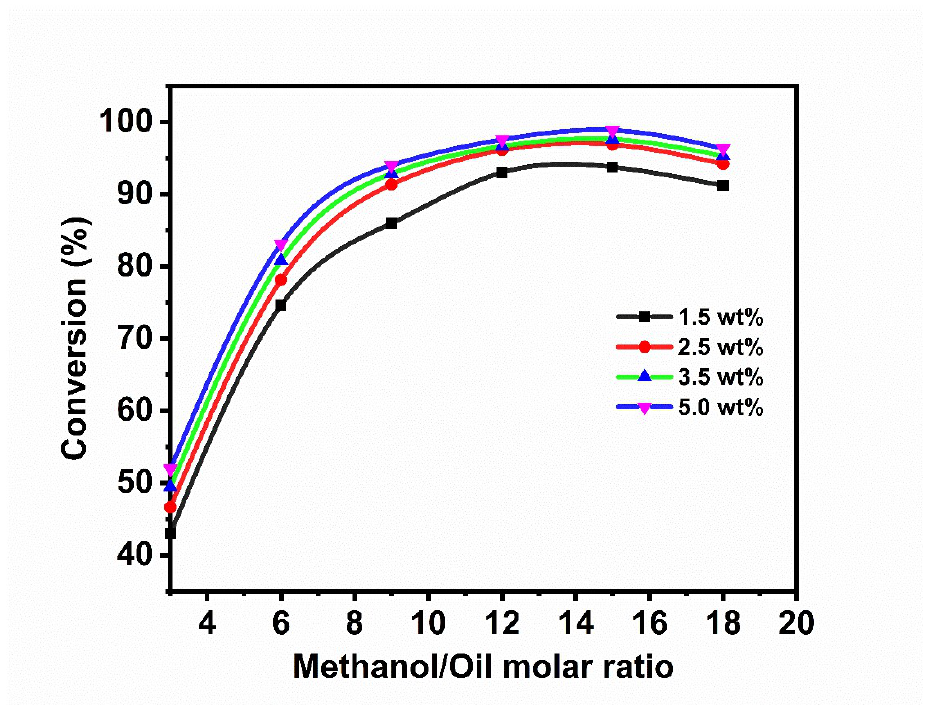
Figure 9. Effect of the molar ratio methanol/refined oil on the biodiesel production at different catalyst Figure 9. E ff ect of the molar ratio methanol / refined oil on the biodiesel production at di ff erent catalyst weight loadings and a reaction temperature of 65 °C. weight loadings and a reaction temperature of 65 ◦